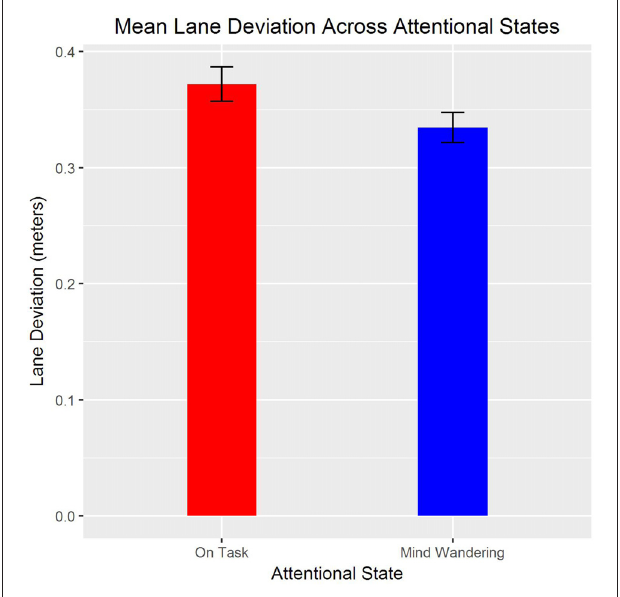
FIGURE 5 | Means and standard errors of lane deviation for “mind wandering” and “on task” attentional states.